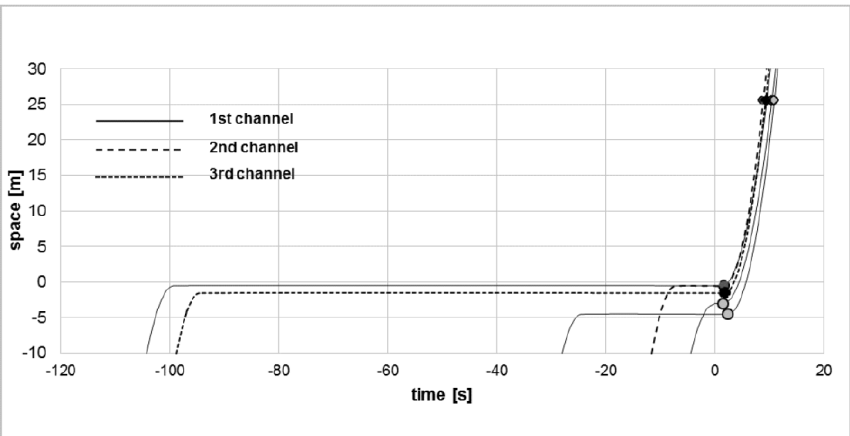
Figure 15. Space-time diagram for cyclists in the Q(5,3) multichannel